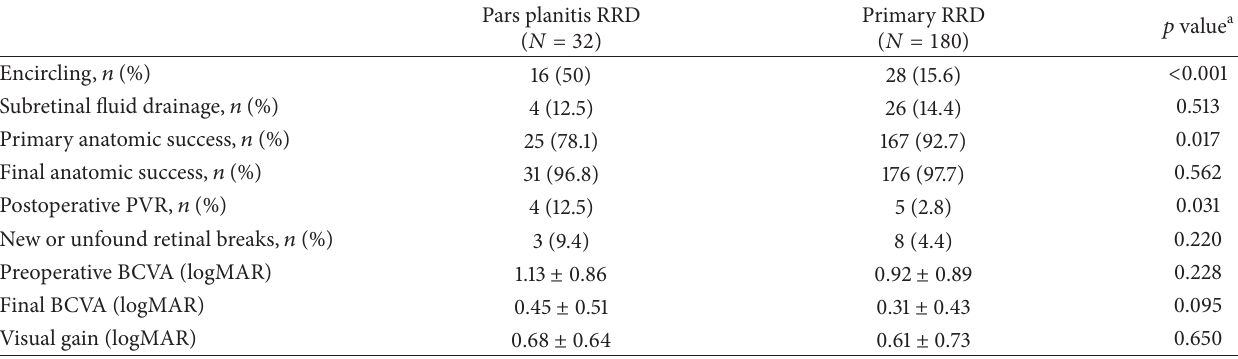
Table 2: Surgical and visual outcomes of pars planitis associated rhegmatogenous retinal detachment (RRD) patients and primary RRD patients.